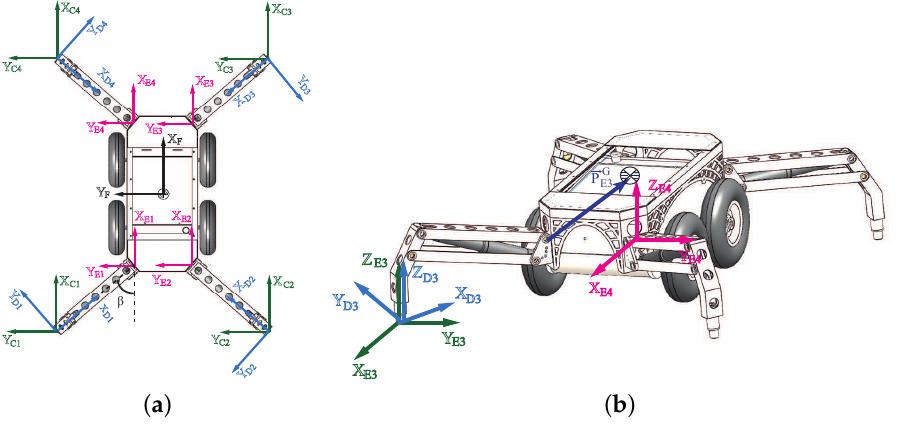
Figure 5. ( a ) top view of the platform; ( b ) front view of the